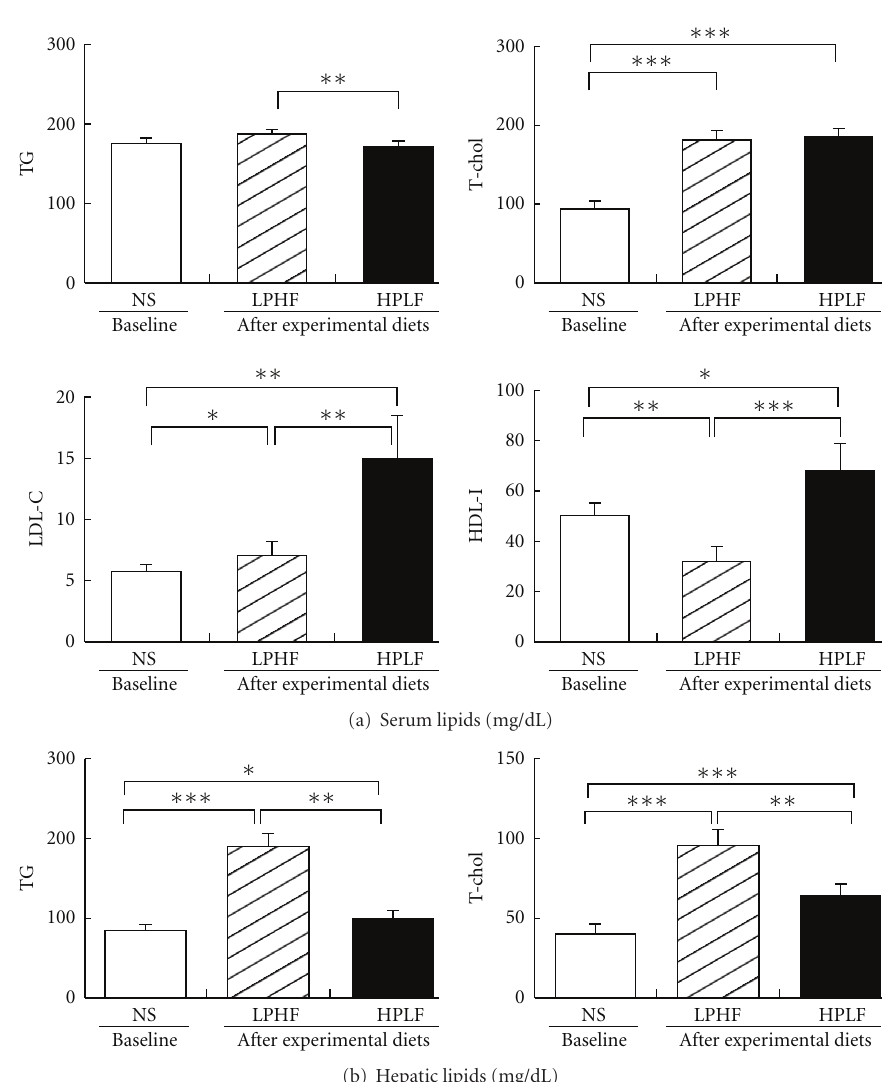
Figure 1: Serum and hepatic lipids. NS: weekly intraperitoneal injection of adriamycin (2mg/kgBW) for six weeks. LPHF: weekly intraperitoneal injection of adriamycin (2mg/kgBW) for 6 weeks thereafter a 7% protein and 40% fat diet for 5 weeks. HPLF: weekly intraperitoneal injection of adriamycin (2mg/kgBW) for 6 weeks thereafter a 30% protein and 7% fat diet for 5 weeks.TG: triglyceride, T- chol: total-cholesterol, LDL-chol: LDL-cholesterol, HDL-chol: HDL cholesterol. ∗ Statistically di ff erent between the LPHF and HPLF groups by student’s t -test at P < . 05, ∗∗ P < . 01, ∗∗∗ P < . 001.